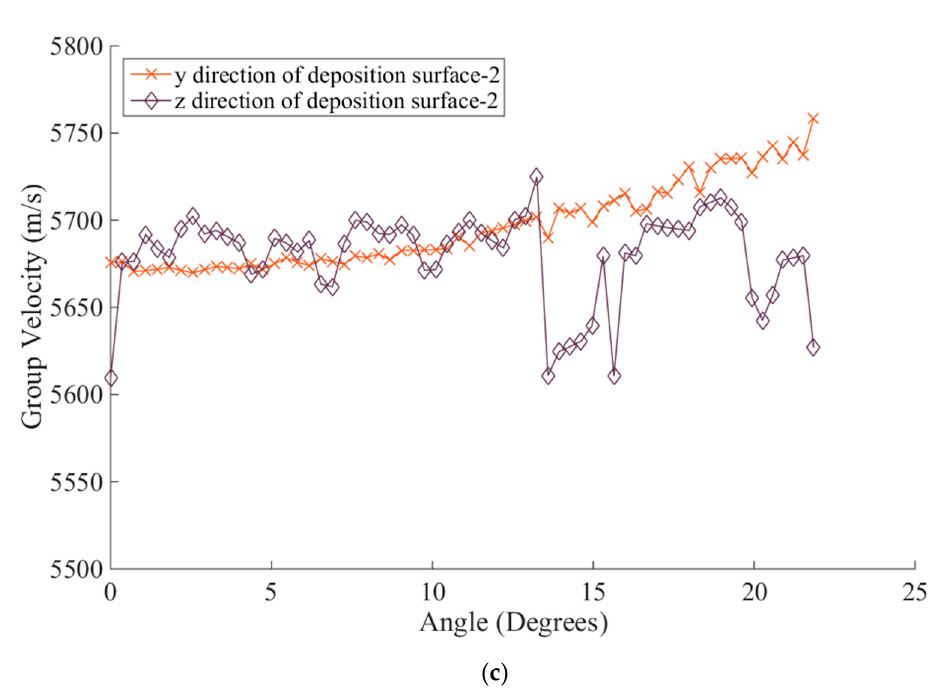
Figure 5. The results of group velocity measurement of different surfaces. ( a ) The variation relationship between the fitting curve of group velocity and angles when the acoustic wave is emitted along the deposition direction. ( b ) and ( c ) are the variation relationship between group velocity and angles when the acoustic wave is emitted perpendicular to the deposition direction.